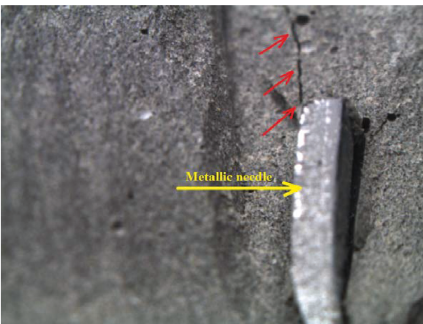
Figure 10: A microcrack propagation along the metallic needle embedded in hydrated cement paste. The crack continues the vertical direction of the needle side